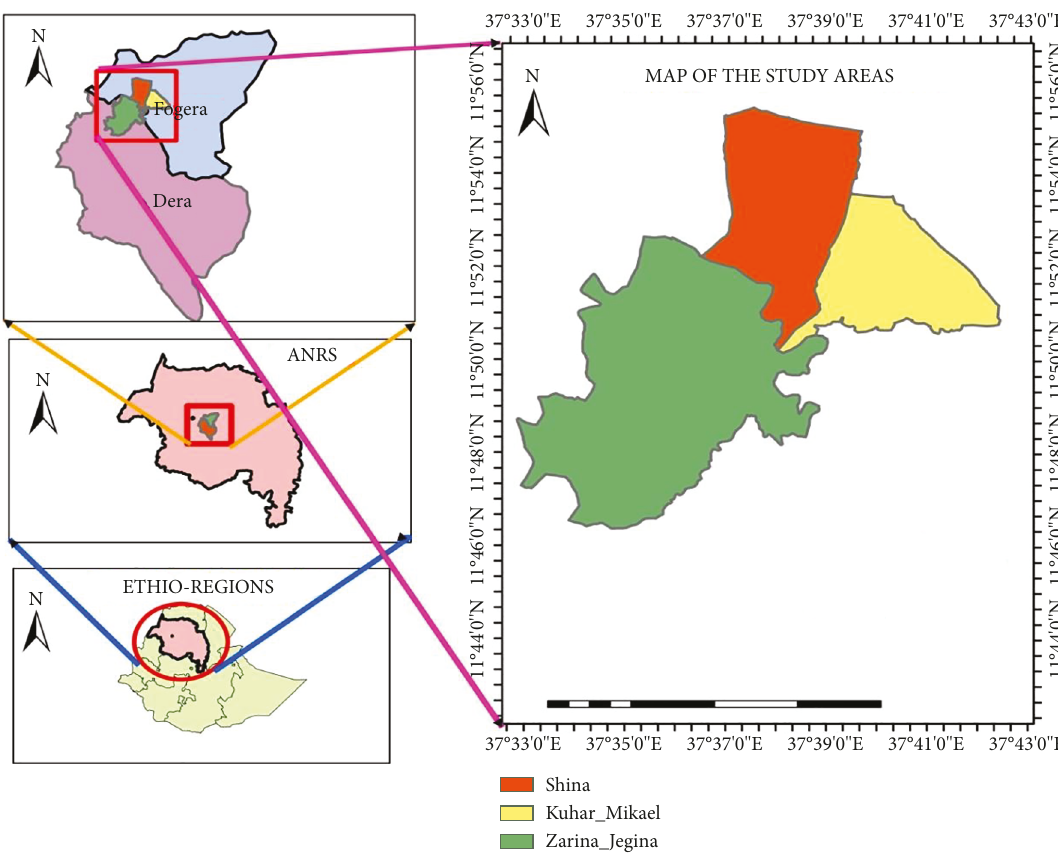
Figure 1: Map of the study